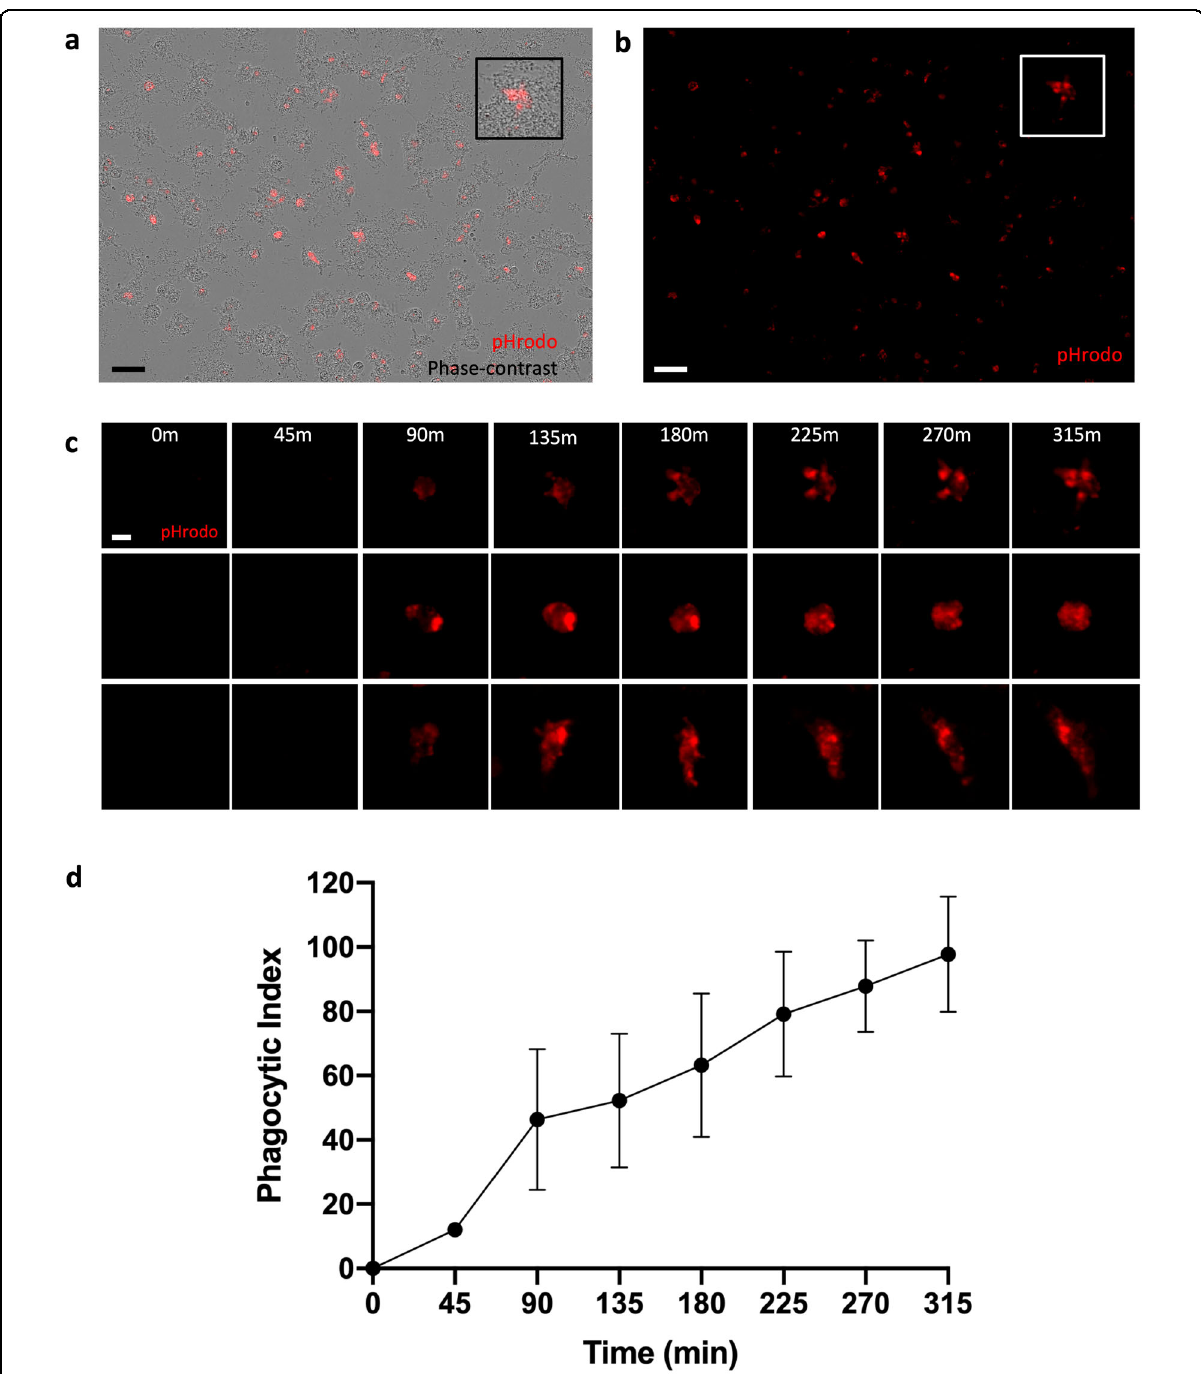
Fig. 5 Functional characterization of synaptosome engulfment by CB-iMGs derived from CB-MNCs exposed to maternal SARS-CoV-2 infection. a Representative live real-time images in phase contrast/red fl uorescence overlay mode showing cellular uptake and b red fl uorescence channel alone of pHrodo (red)-labeled synaptosomes uptake at the end of the phagocytosis assay (315 min). Scale bar: 60 μ m (boxes show the magni fi ed view of engul fi ng CB-iMG). c Representative pHrodo (red)-labeled synaptosome engulfment in exposed CB-iMGs during live real-time imaging used for quanti fi cation. Scale bar: 20 μ m. d Quanti fi cation of labeled synaptosome uptake by exposed CB-iMGs cells during live imaging. The phagocytic index represents the mean pHrodo + area per iMG cell over N = 8 fi elds per well × 3 wells per line and N = 2 separate SARS-CoV-2- exposed CB-IMG line derivations. Error bars represent